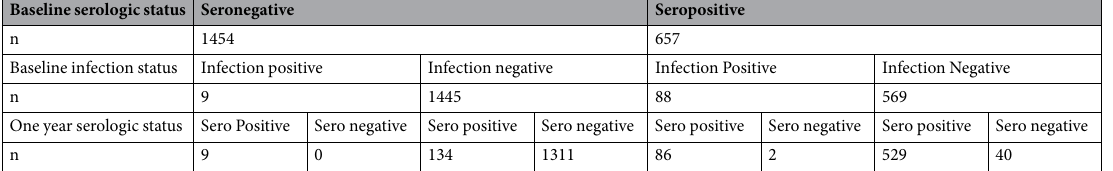
Table 5. Serologic status and infection status at baseline, and one year serologic status.